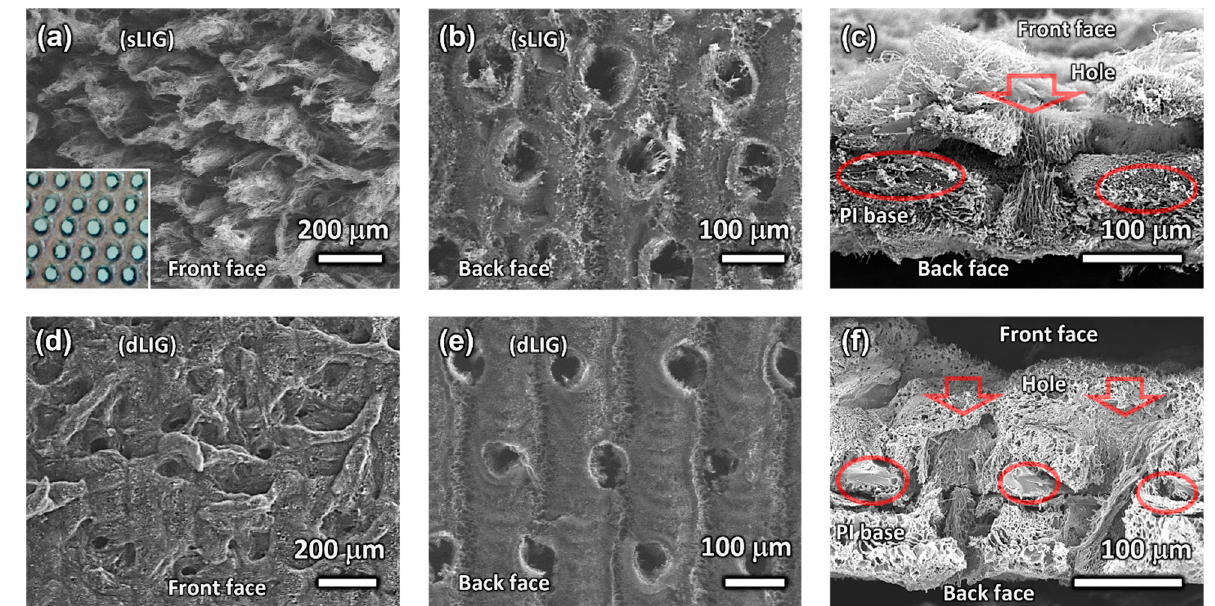
Figure 3. SEM images of different views of different LIG filters. Top-down view on ( a ) the front side of the SF-sLIG filter, ( b ) the back side of the DF-sLIG filter, ( d ) the front side of the SF-dLIG filter, and ( e ) the back side of the DF-dLIG filter. Cross-sectional view of ( c ) the DF-sLIG filter and ( f ) the DF-dLIG filter; the red arrows denote holes with corresponding size; the ovals denote traces of remaining PI film base.